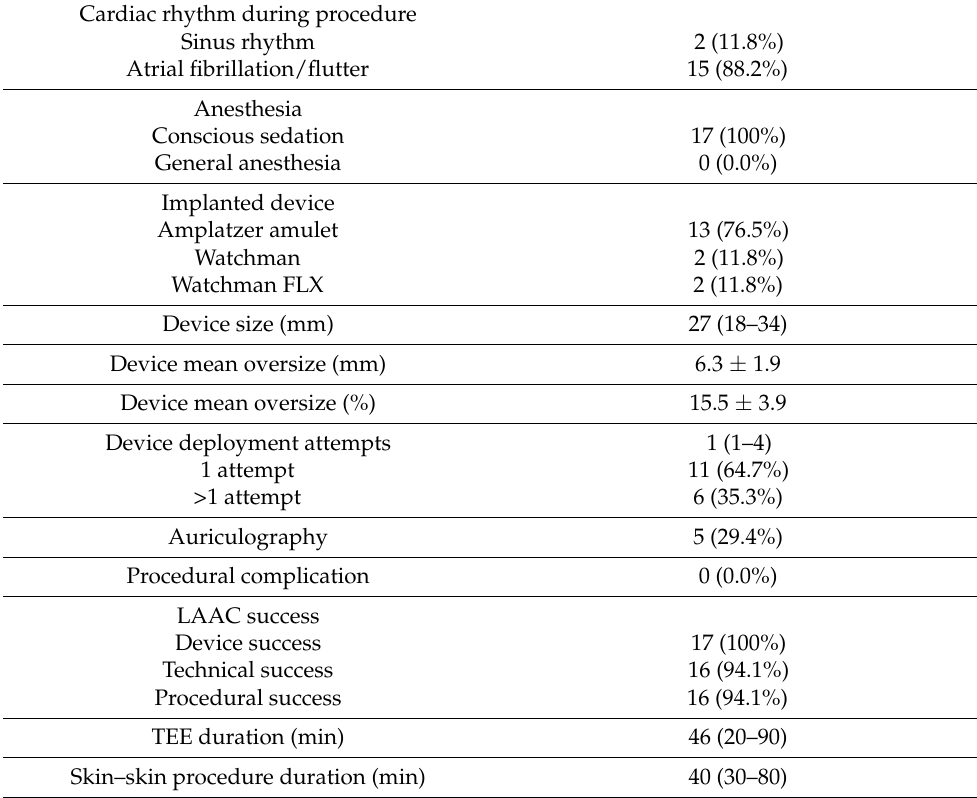
Table 3. Characteristics of percutaneous left atrial appendage closure